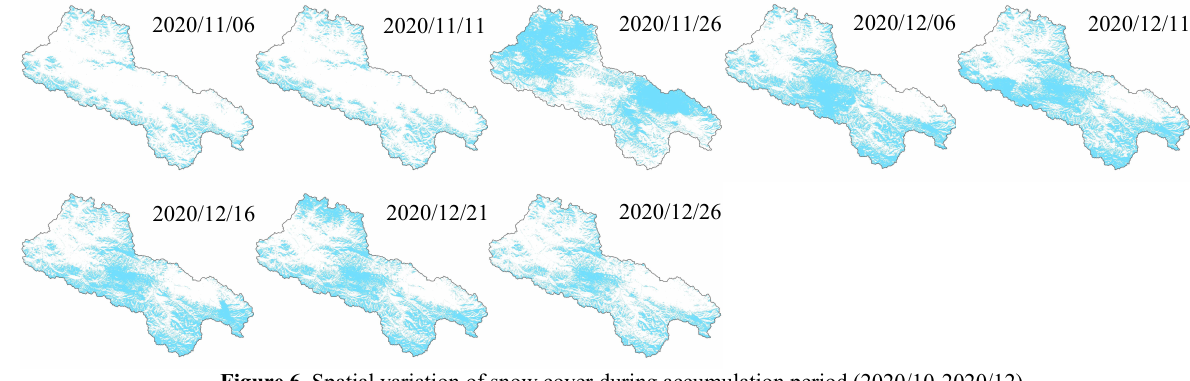
Figure 6. Spatial variation of snow cover during accumulation period (2020/10-2020/12).